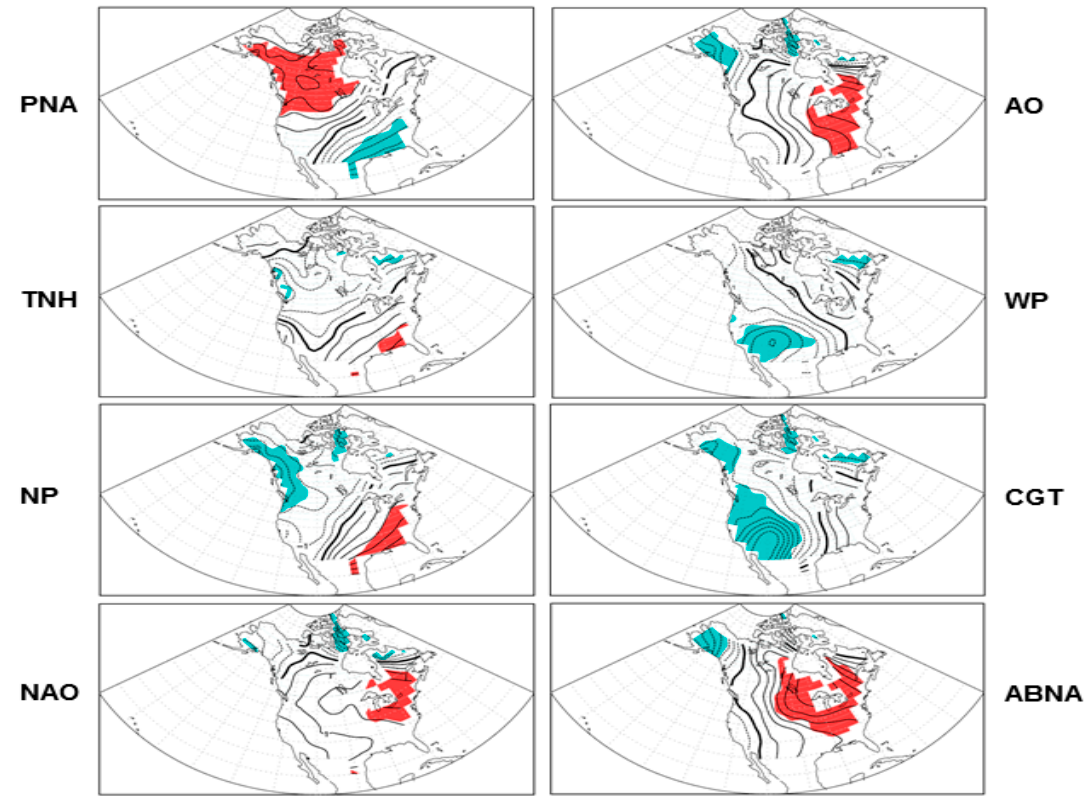
Figure 4. As in Figure 3, but for anomalies of percentages of warm days (TX90p) with contour interval 0.5%.